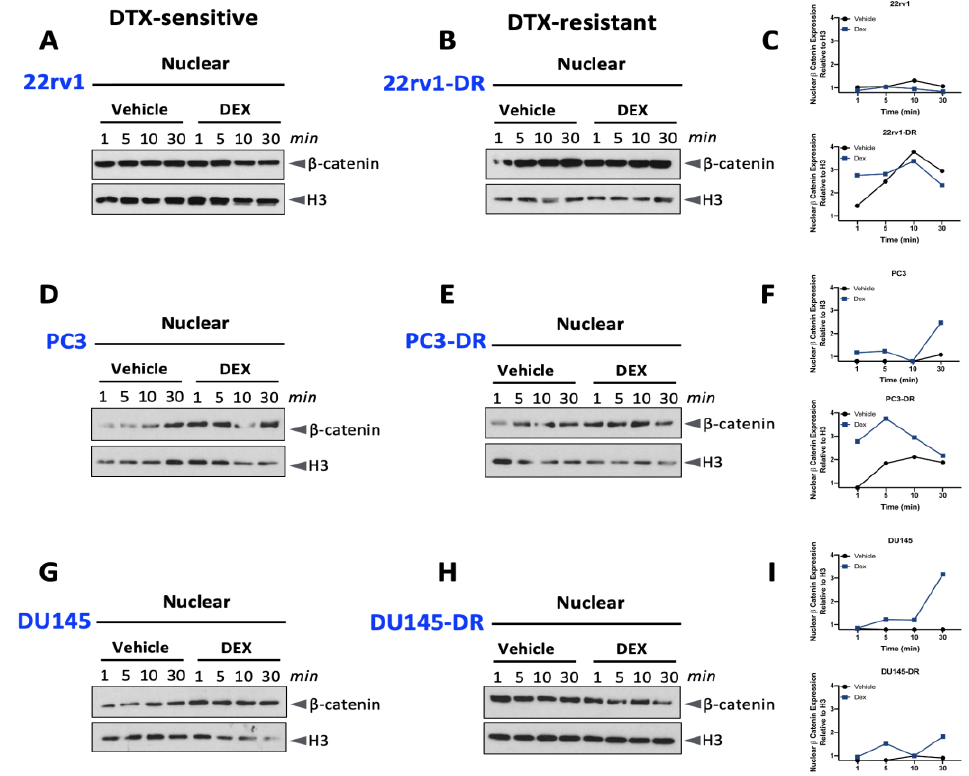
Figure 3. Total β-catenin nuclear translocation in DTX-sensitive and DTX-resistant PCa cells after dexamethasone treatment. Following growth for 12 h in medium containing CS- FBS, DTX-sensitive, and DTX-resistant 22rv1, PC3, and DU145 cells were treated with 10 nM dexamethasone for the indicated times, and soluble nuclear proteins were extracted for immunoblotting detection of GR and β-catenin in ( A ) 22rv1, ( B ) 22rv1-DR, ( D ) PC3, ( E ) PC3-DR, ( G ) DU145, and ( H ) DU145-DR cells. The blots included in this figure were quantified to show nuclear β-catenin expression in dexamethasone-treated cells (blue squares) compared to vehicle-treated cells (black circles) ( C , F , I ). Histone H3 was used as a marker for nuclear fractions.